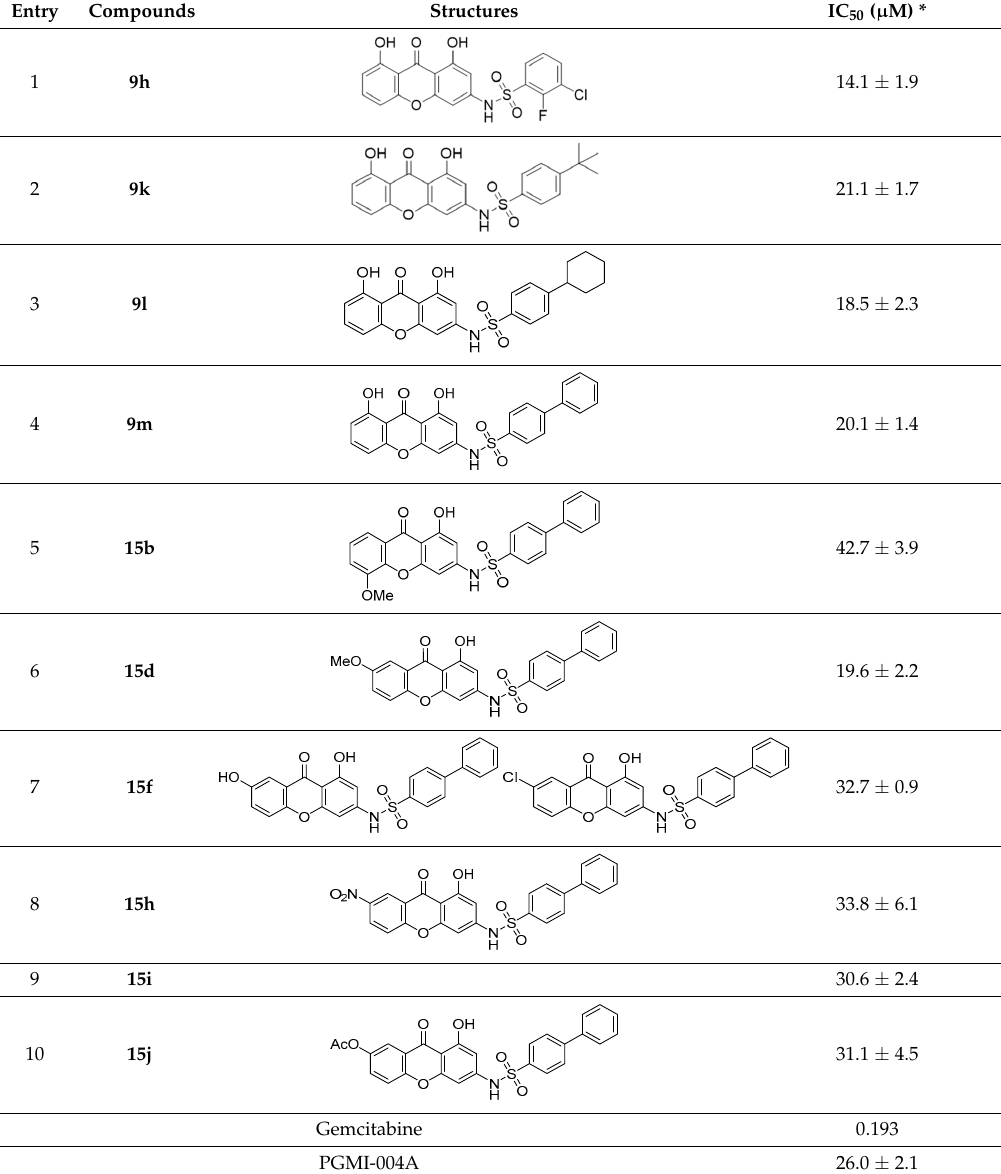
Table 4. Antiproliferation activities of representative compounds. Structures